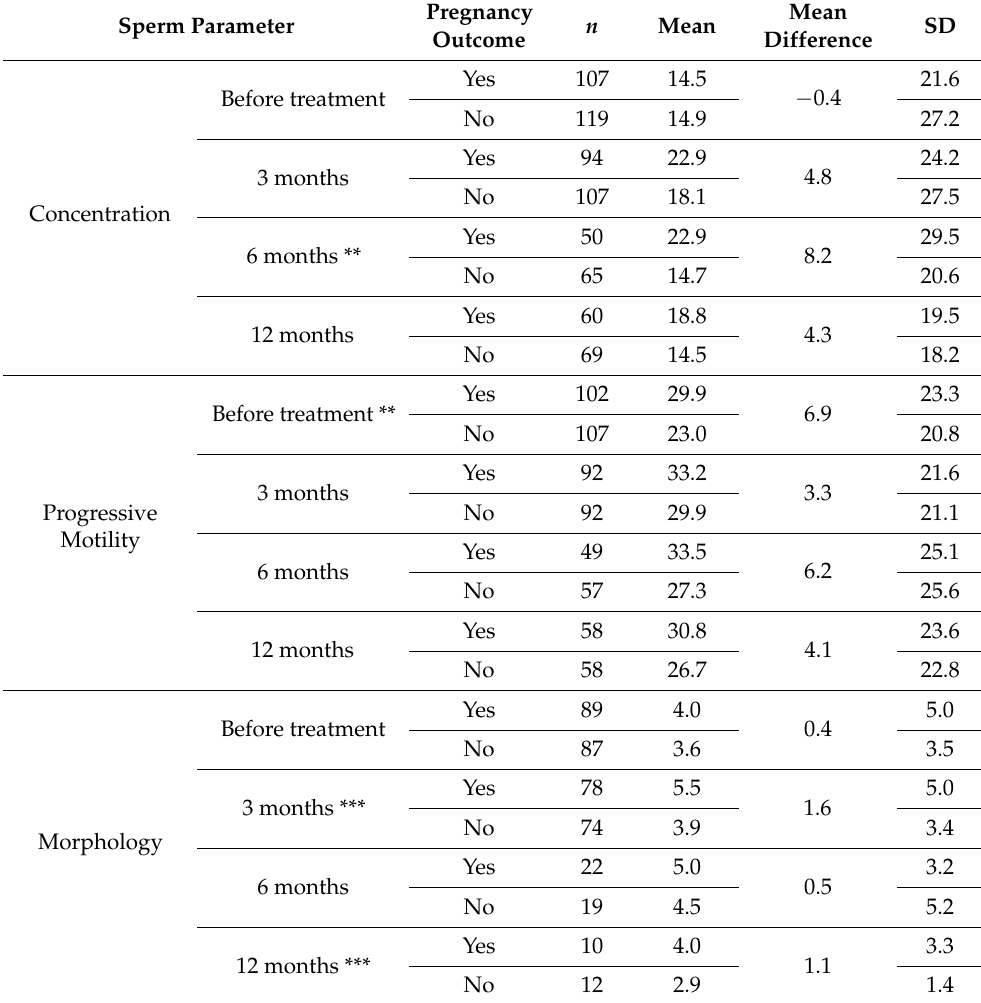
Table 1. Pregnancy outcome vs sperm parameter mean values through patient’s follow up